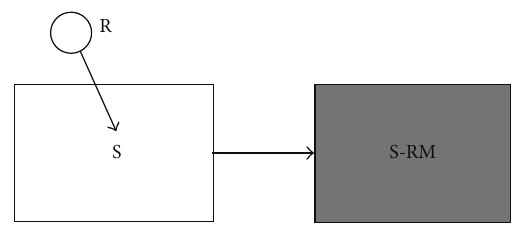
Figure 4: Schematic diagram of calculation for single inclusion